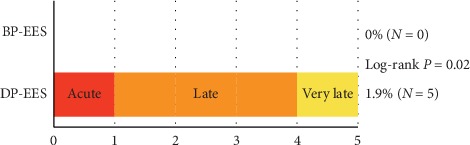
Definite ST through 3 years.